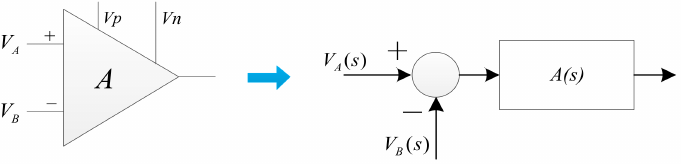
Figure 2. The control block diagram of an operational amplifier.